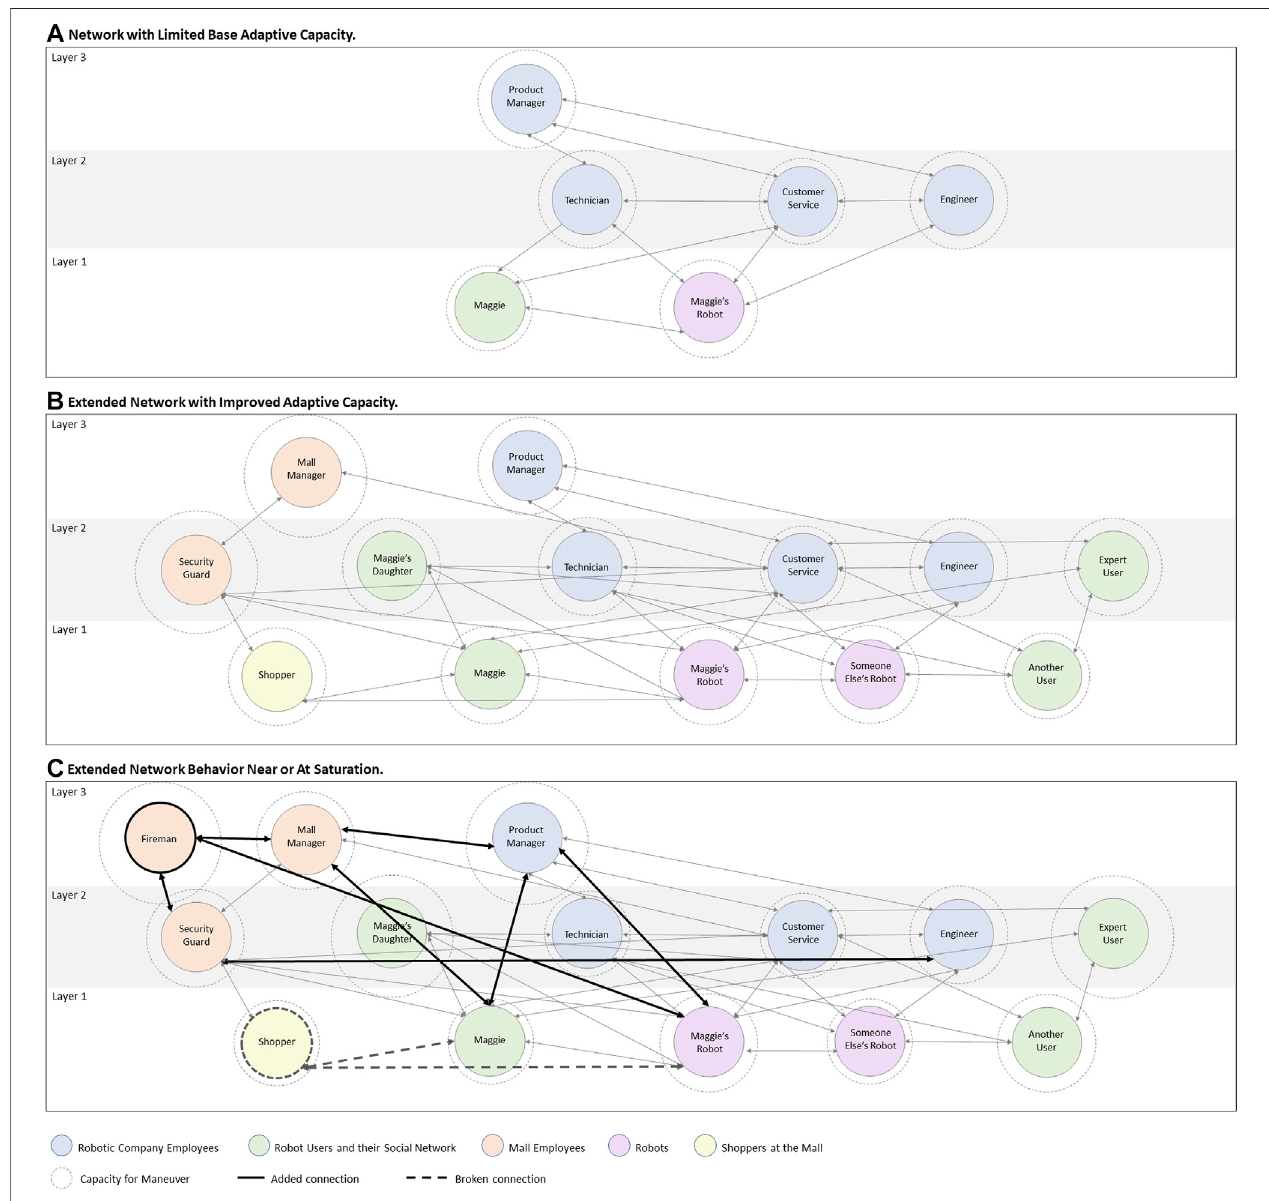
FIGURE 1 | Tangled Layered Networks of socio-technical relations in the Human-Robot Ecosystem (HRE), (A) with limited base Adaptive Capacity, (B) with improved base Adaptive Capacity, (C) adapting in response to an unexpected event that challenged the network.